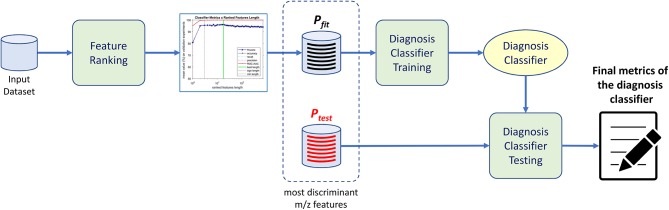
Diagnosis classifier training and testing procedure. Upon receiving data from different patients, we train the proposed method and rank the most important features through an analysis of feature distribution. Thereafter a classifier is trained with the selected featured of interest yielding the diagnosis classifier ready to evaluate different patients data.